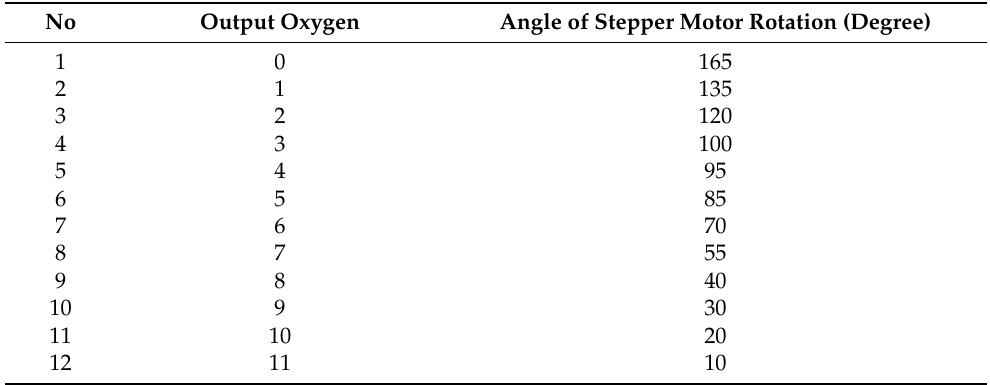
Table 3. Lookup table for oxygen output and angle of stepper motor